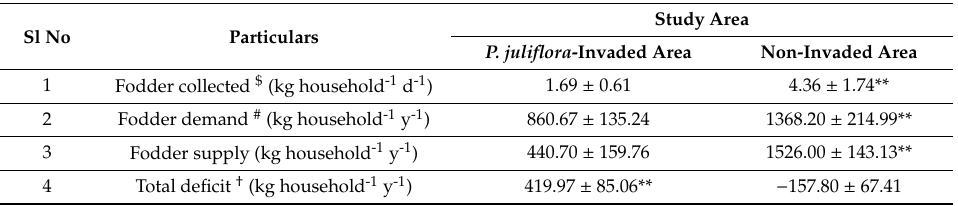
Table 5. Estimation of fodder availability in the P. juliflora -invaded and non-invaded area to feed livestock per year (Mean ± SD).